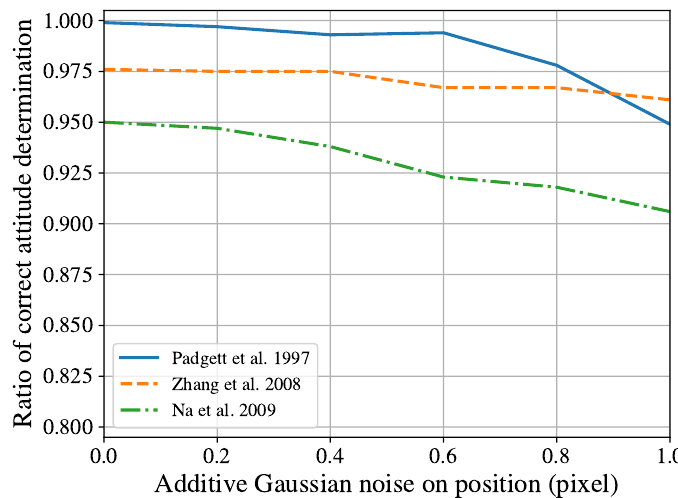
Figure 5. Behaviour of grid algorithm in different test configurations, which were reproduced from Padgett et al. [15]: FOV = 8 × 8 degrees, resolution = 512 × 512, Mv = 7.5, g = 40; Zhang et al. [16]: FOV = 12 × 12 degrees, resolution = 1024 × 1024, Mv = 6.0, g = 40; Na et al. [17]: FOV = 8 × 8 degrees, resolution = 512 × 512, Mv = 6.5 and g =